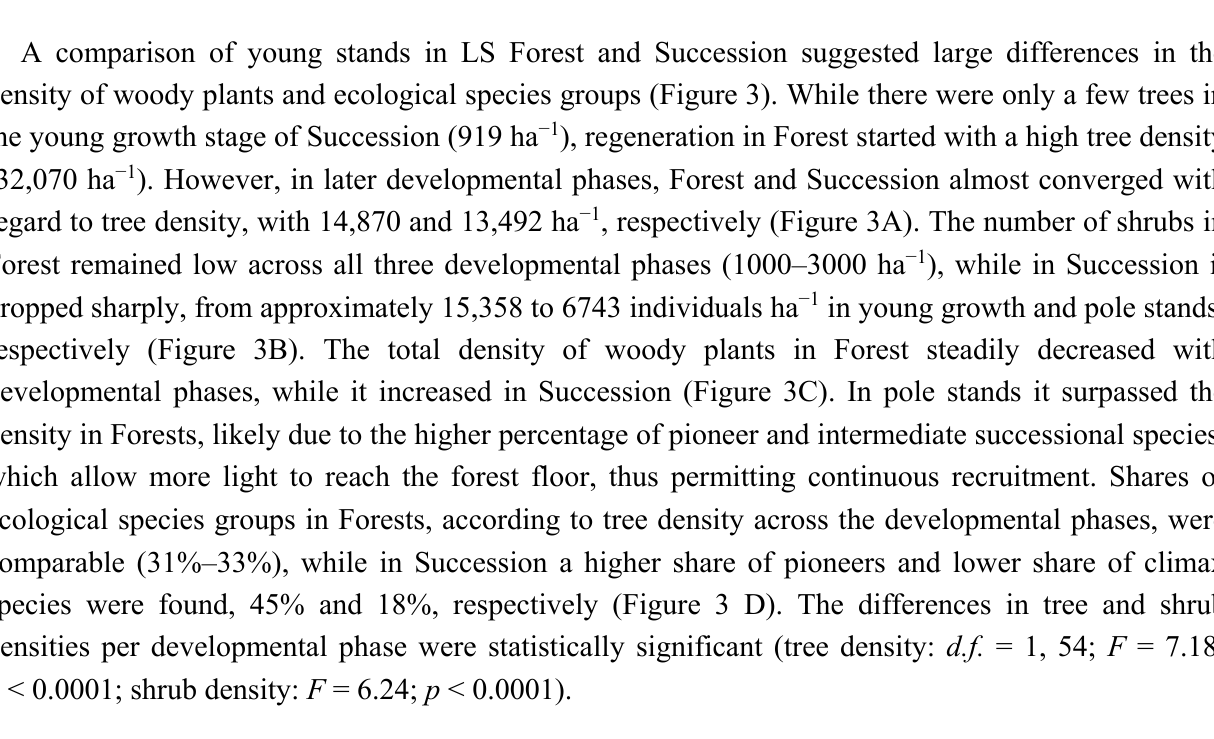
Figure 3. The density of trees ( A ); shrubs ( B ); and the total density of woody plants ( C ) by developmental phase in Forest and Succession; the percentage of ecological species groups in Forest and Succession according to tree density ( D ); N = 37 plots for Forest and 15 plots for